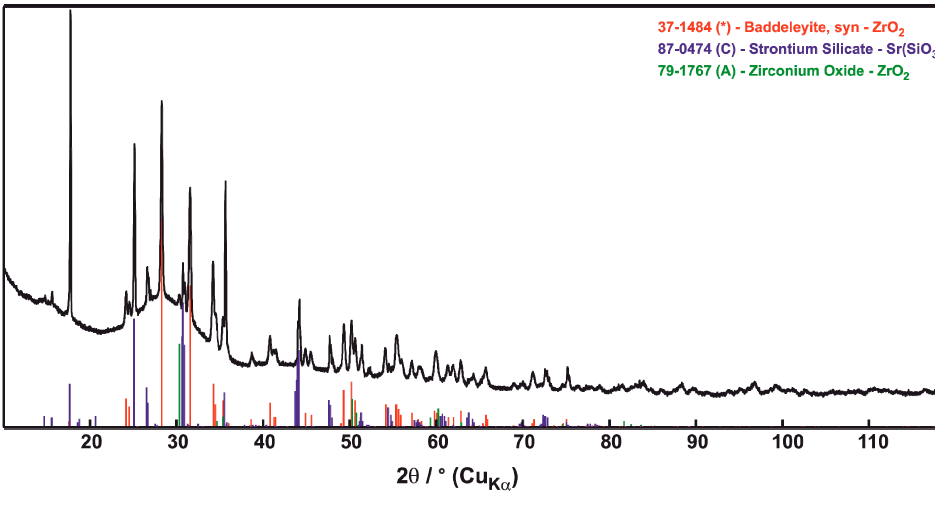
Figure 6. XRD patterns of the sample “8 h”.